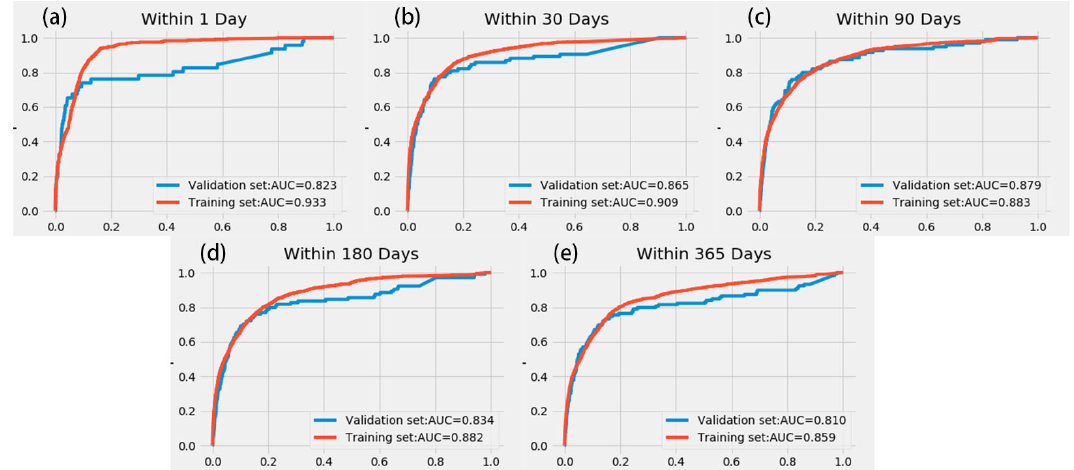
Figure 2. ROC (receiver operating characteristic) curve for multiple timescales. Panels (a) through (e) show the ROC curve of the model within 1, 30, 90, 180 and 365d, respectively. The horizontal axis represents the FPR (false positive rate), and the vertical axis represents the TPR (true positive rate).